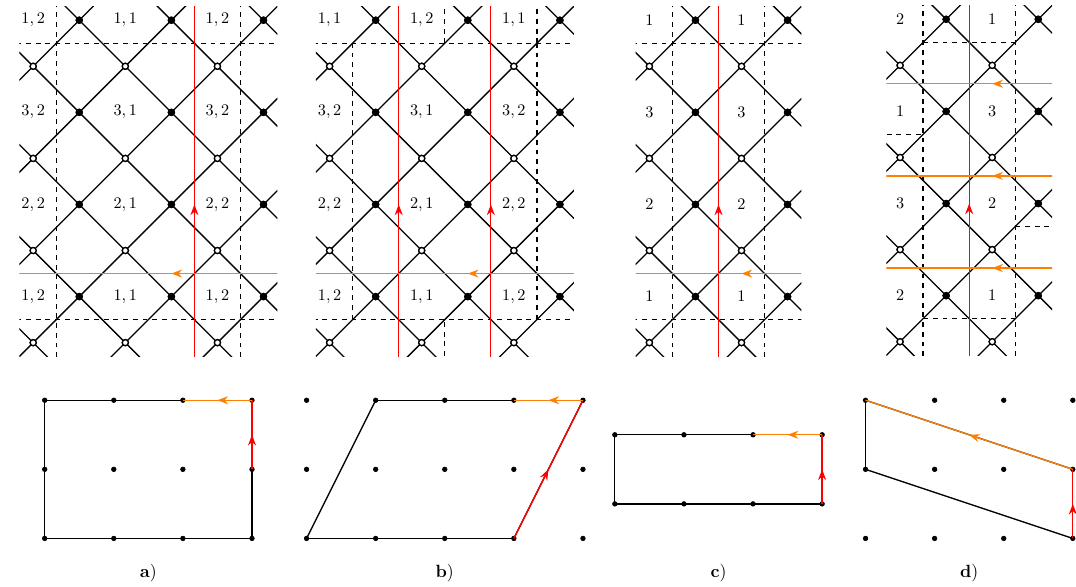
Figure 9 . Examples of twisted gl chains. Dashed lines bound fundamental domains. We use 2 di(cid:11)erent notations for zig-zags here, comparing to the pictures above. Edges crossed by red arrows belong to (cid:13) 2 zig-zag, orange arrows are for (cid:11) 1 . a, b) XXZ chain of rank two and its twisted cousin. Note that the twisted twice chain is equivalent up to SL(2 ; Z ) transformation (cid:21) ! (cid:21)(cid:22) to the untwisted chain, as Q 2 = (cid:22) 1 , like in remark 2.2. c, d) Making Toda chain by twisting gl (cid:3) chain dual to gl 1